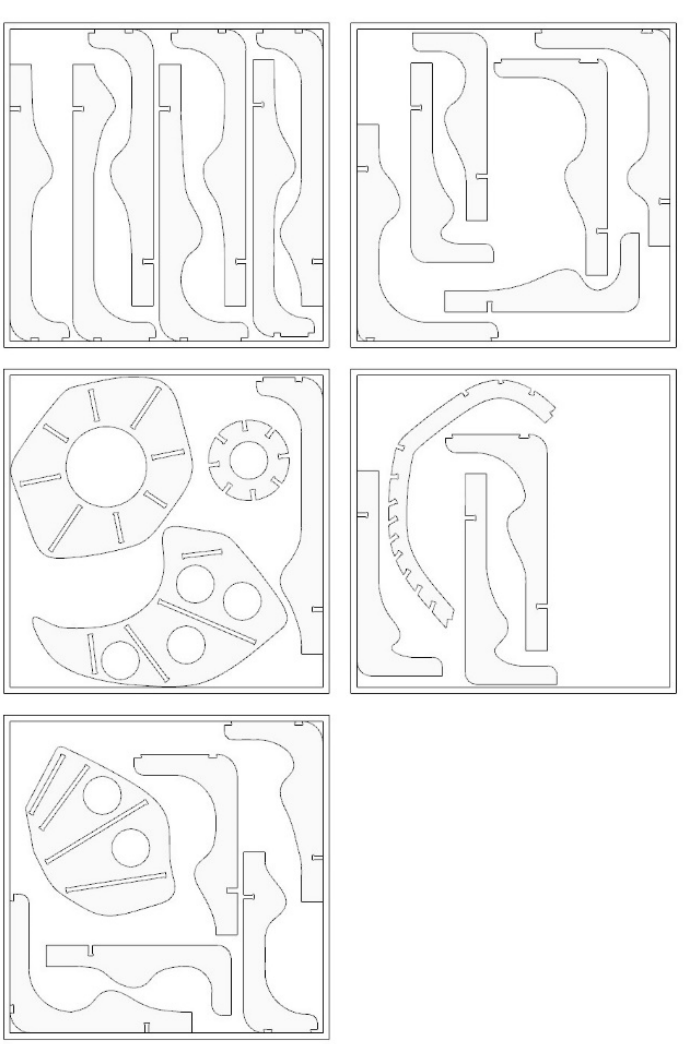
Figure 8. Nesting of the structural